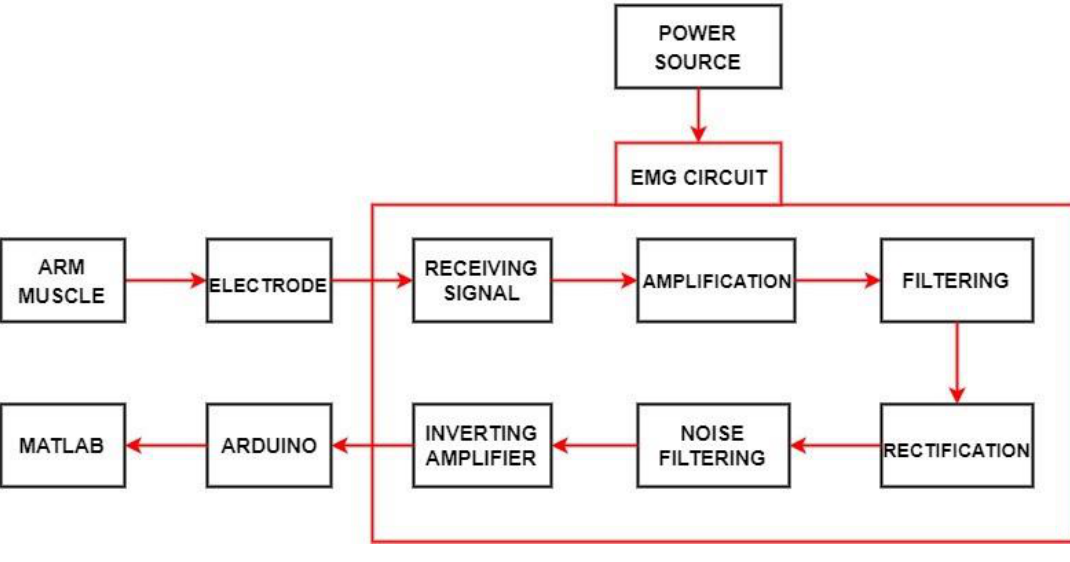
Figure 5. Block diagram of EMG